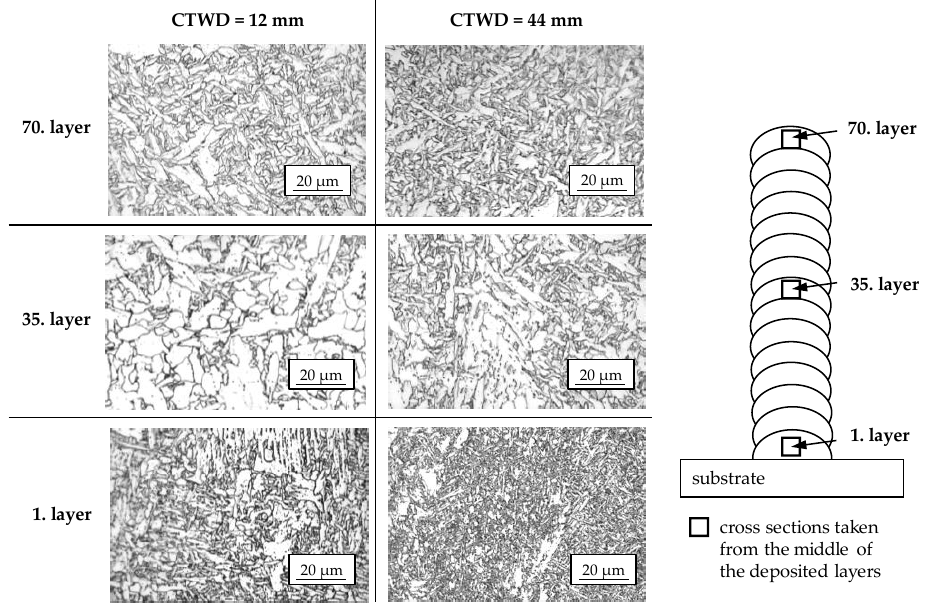
Figure 14. Microstructural cross sections of additively manufactured walls with differing CTWD for U = 20 V; v wire = 5 m/min and v weld = 0.4 m/min.